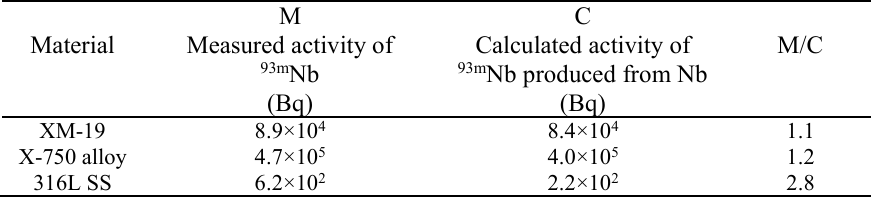
Table 4. Comparison of the measured activity of 93m Nb and the calculated activity of 93m Nb produced from